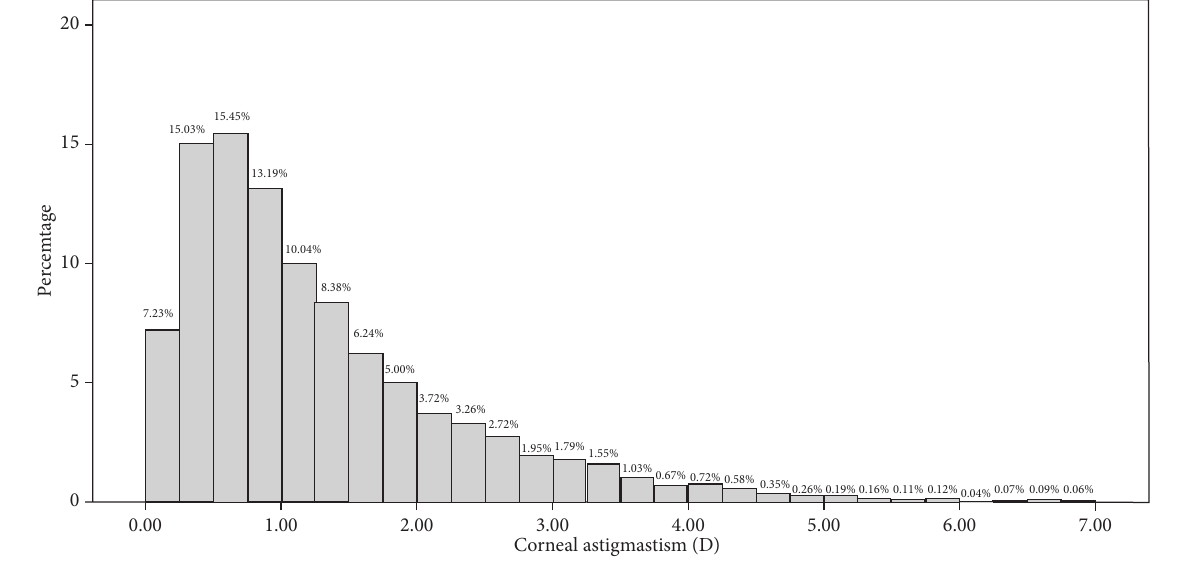
Figure 1: Distribution of corneal astigmatism. Table 2: Comparisons of parameters of the ARC patients by sex and age group.